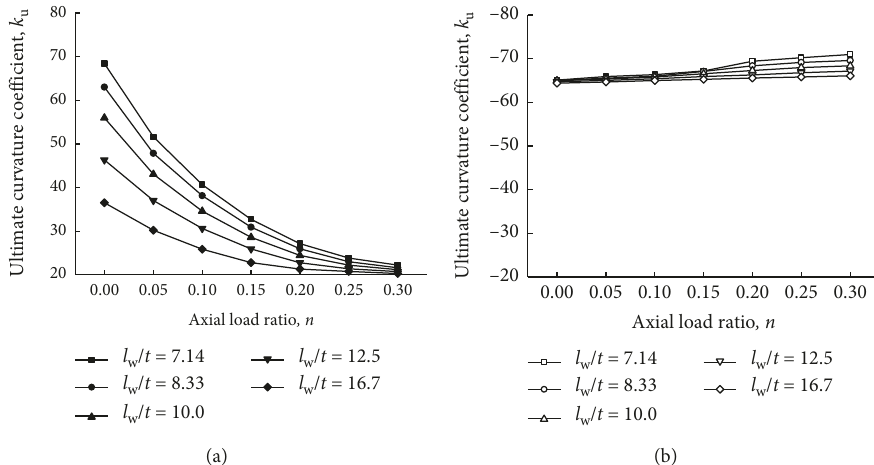
Figure 18: Variations in the ultimate curvature coefficient with the axial load ratio at different web height to thickness ratios. (a) Flange in tension. (b) Flange in